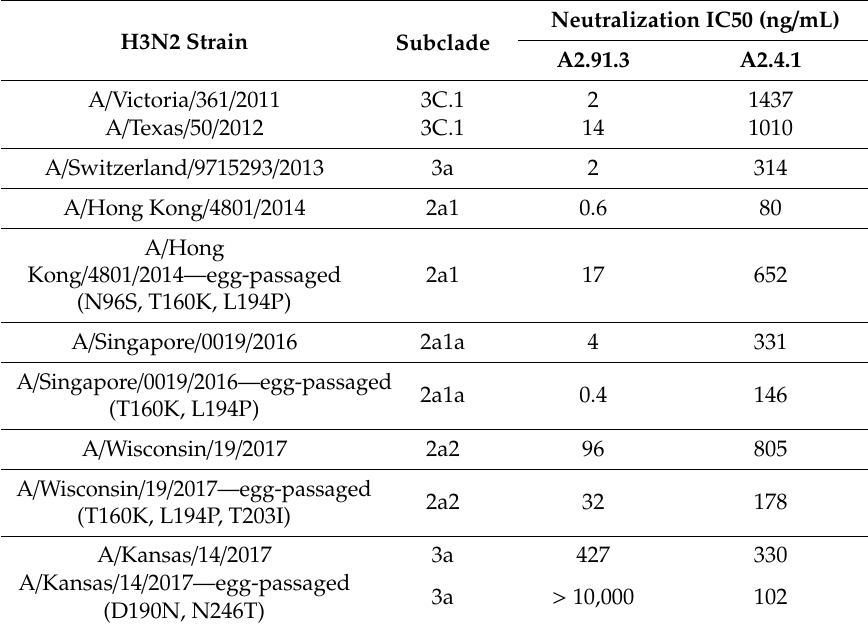
Table 1. Neutralization of recent wild-type and egg-passaged H3N2 strains.